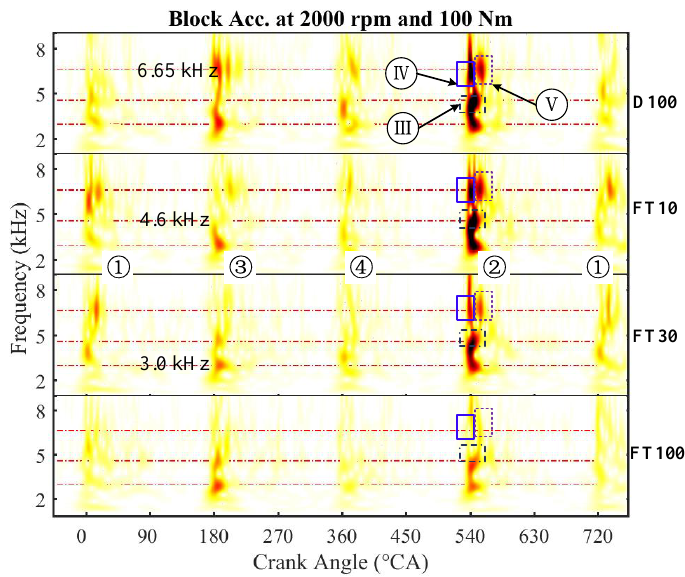
Figure 11. CWT transformation of engine block vibration signal.